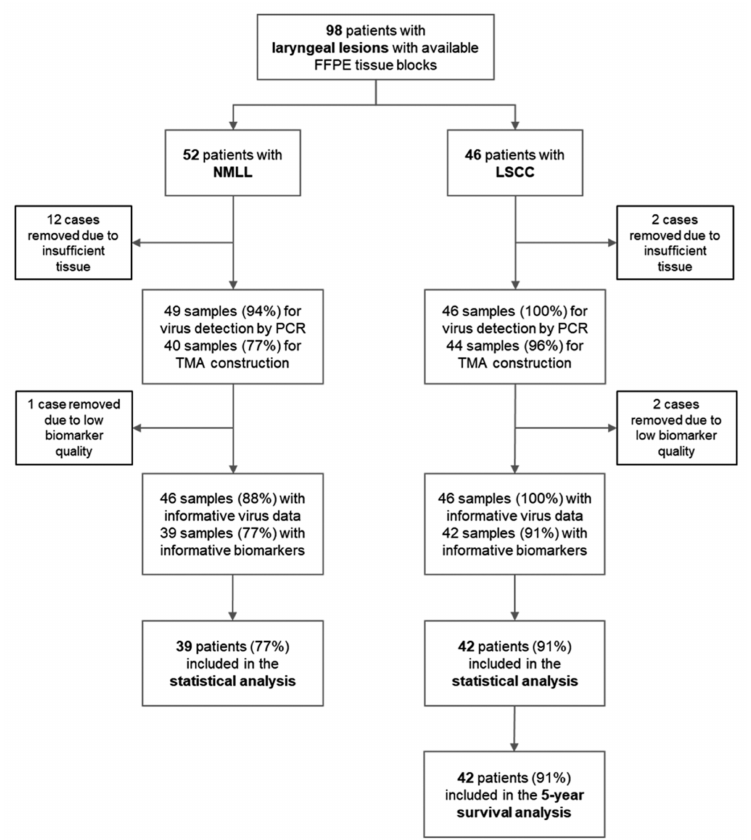
Figure 1. REMARK diagram. There were 94 patients with laryngeal lesions with available formalin- fixed paraffin-embedded (FFPE) tissue blocks. Seventeen cases with inadequate tissue and low- quality biomarkers were excluded. Therefore, 42 patients with laryngeal squamous cell carcinoma (LSCC) and 39 sex-matched control patients with a non-malignant lesion of the larynx (NMLL) were included in the final statistical